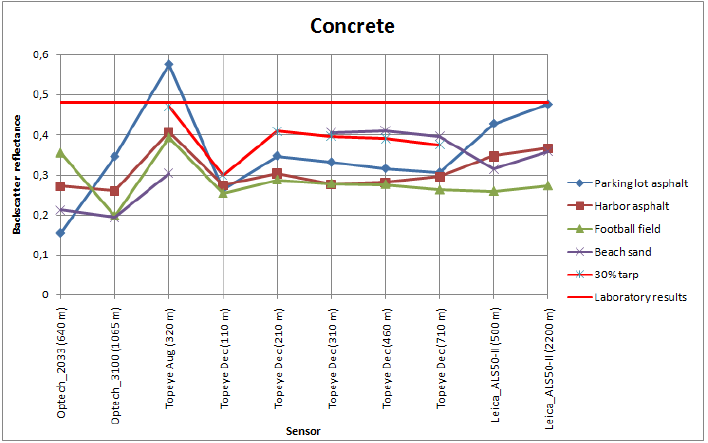
Figure. 7G. Backscatter reflectances of the concrete sample calibrated with different samples as reference.